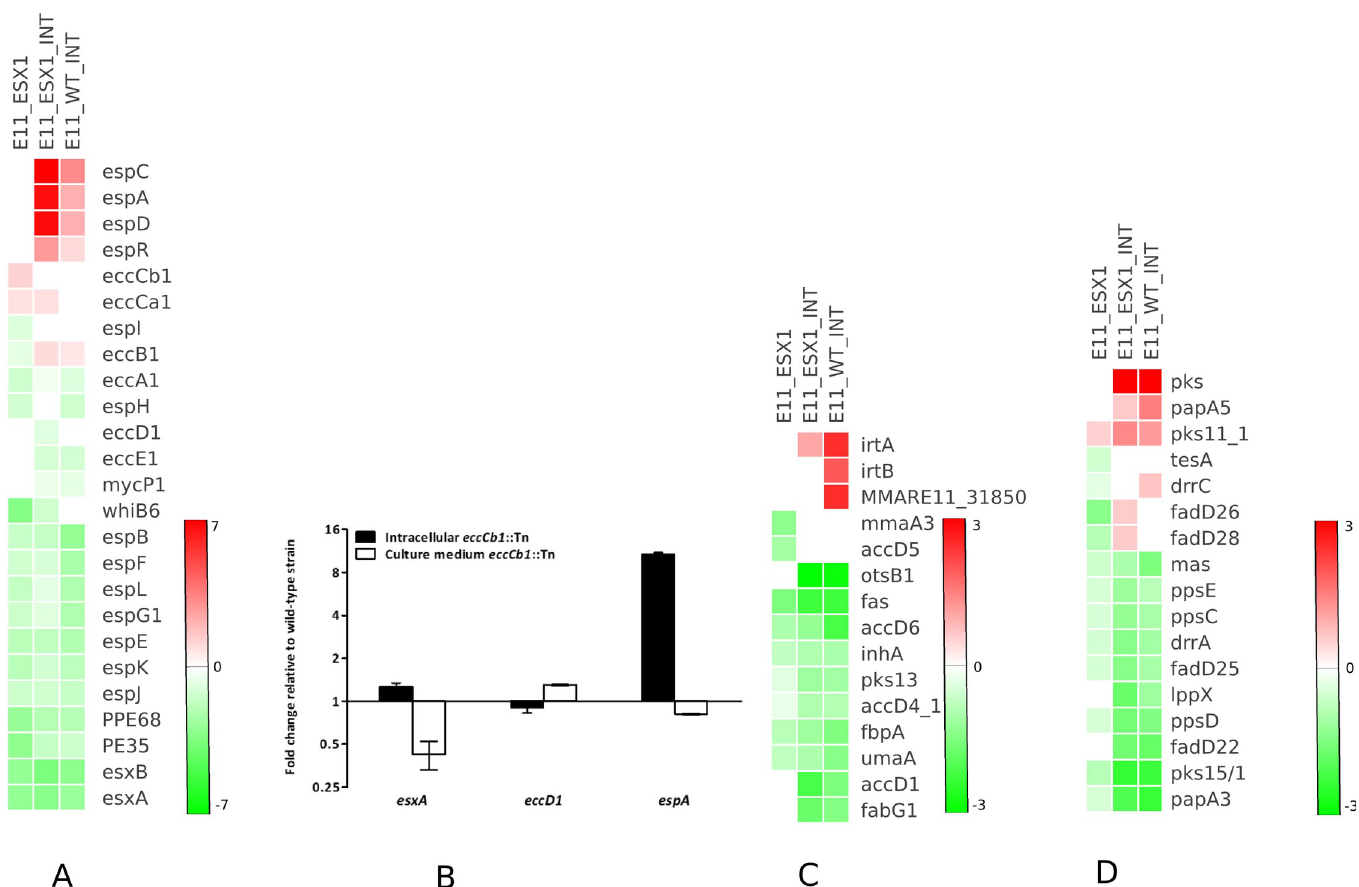
Fig 3. Effect of ESX-1 disruption ( M . marinum eccCb Transposon Mutant) on gene transcription during infection (Indicated as ı´nt’) and growth in culture 1 medium in M . marinum compared to that in the wild-yype strain E11 during growth in 7H9 culture medium. (A) Relative transcript expression levels of the ESX-1 secretion system-associated genes, including the main esx-1 locus as well as the EspR regulator and accessory factors in the espA operon, which is encoded outside the RD- 1 region. (B) Gene expression levels, as measured by qRT-PCR, were compared to those of the wild-type strain E11 grown in similar conditions. Values represent mean ± standard error of the mean of two biological replicates. (C, D) Regulation of genes associated with cell wall synthesis, including genes involved in mycolic acid synthesis (C) and PDIMs (D).